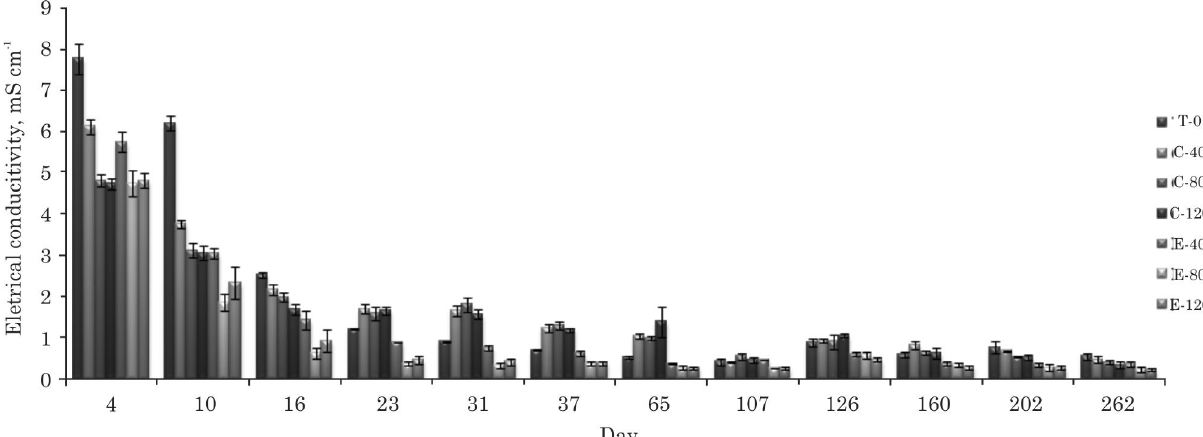
Figure 3. Average values and their respective standard errors of Electrical Conductivity of leachates from leaching columns treated with increasing limestone and steel slag doses, for 262 days.